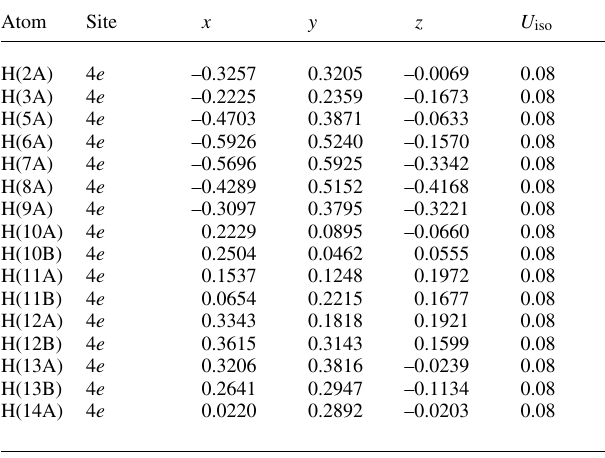
Table 2. Atomic coordinates and displacement parameters (in Å 2 )